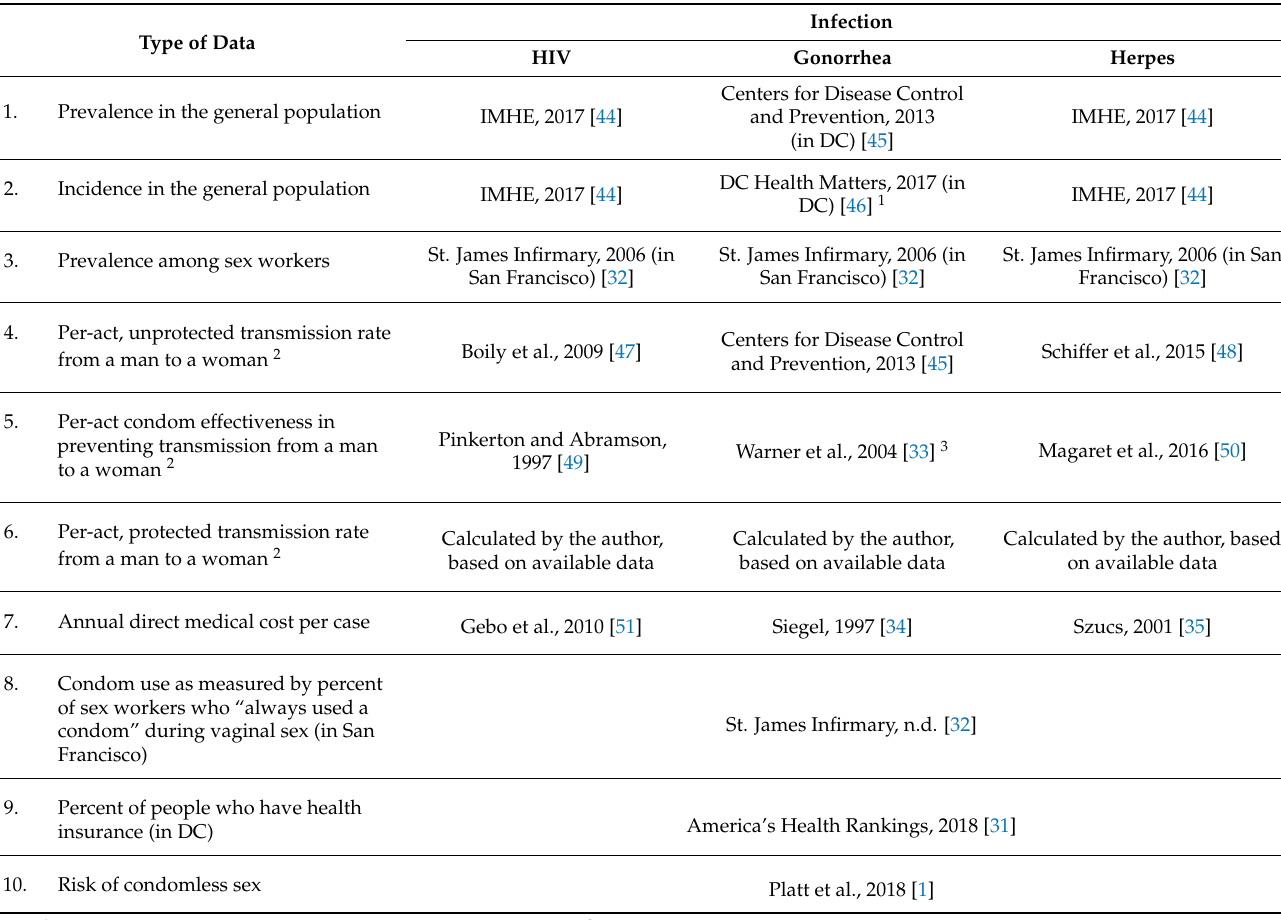
Table 10. Sources of data used to calculate health sector savings due to averted cases of HIV, gonorrhea, and herpes in sex workers following